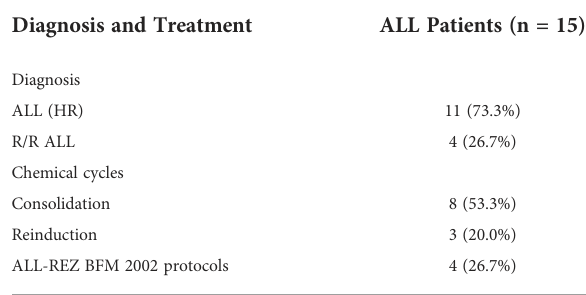
TABLE 1-2 Chemotherapy administered to ALL